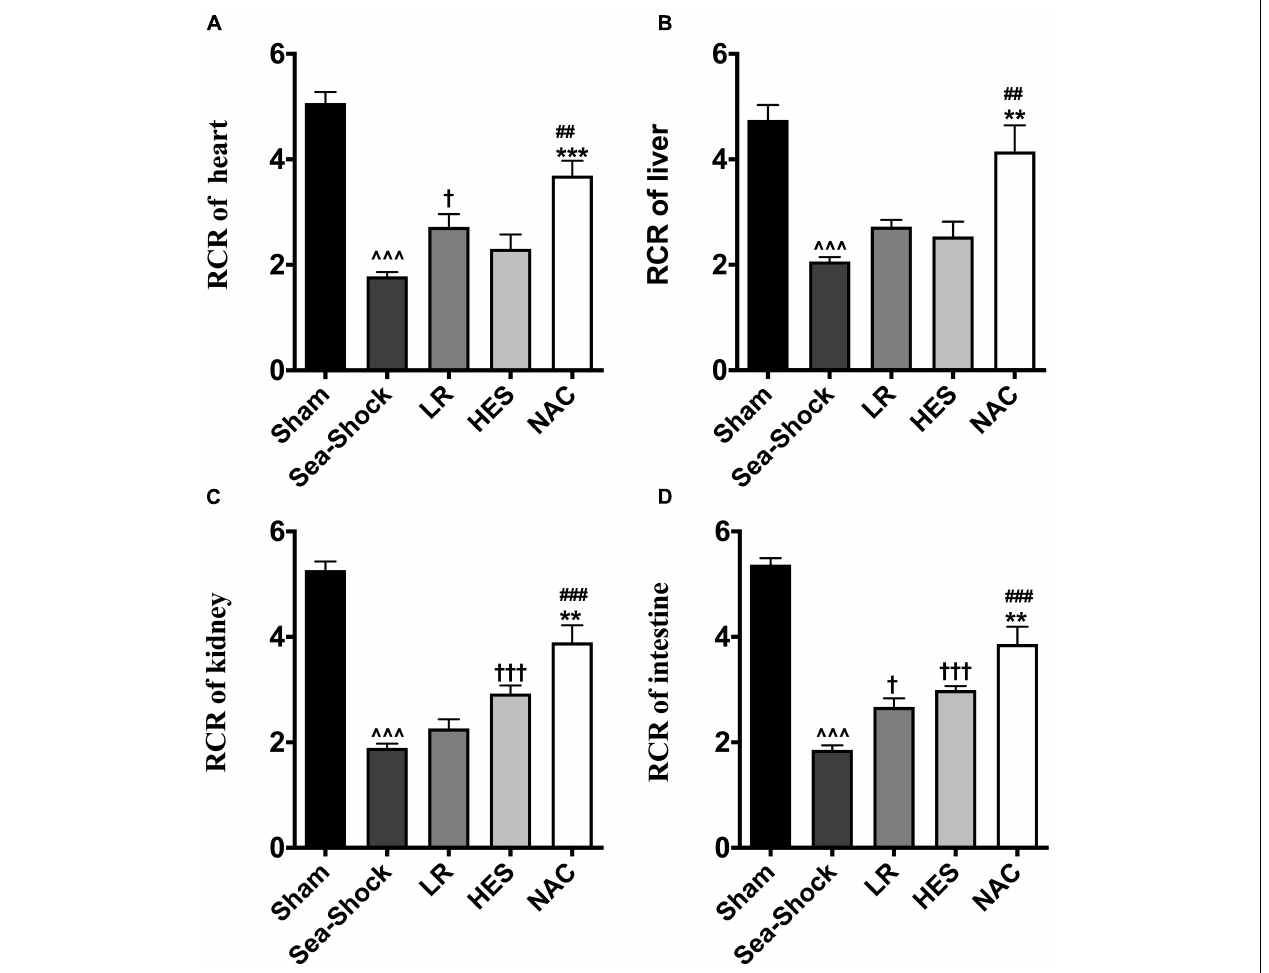
FIGURE 7 | Effects of LR solution, HES solution, and LR solution with the addition of NAC (30 mg/kg) on mitochondrial function. (A) RCR of heart; (D) RCR of intestine; (C) RCR of kidney; (B) RCR of liver. RCR, respiratory control rate; LR, Lactated Ringer’s; HES, Hetastarch; NAC, LR solution with the addition of NAC (30 mg/kg). Data presented as mean ± standard deviation ( n = 8/group). ∧∧∧ P < 0.001, Sea-Shock group versus baseline; † P < 0.05, ††† P < 0.001, LR group or HES group versus Sea-Shock group; ## P < 0.01, ### P < 0.001, LR group versus NAC group; ** P < 0.01, *** P < 0.001, HES group versus NAC